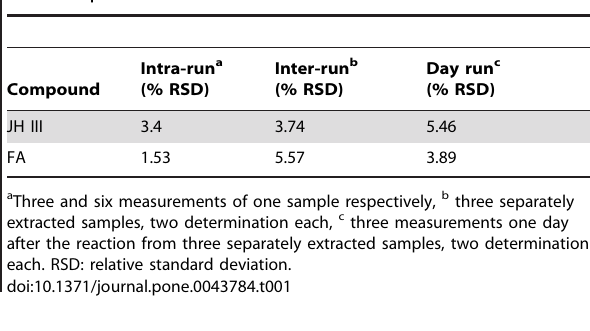
Figure 5. JH III HPLC-FD chromatograms. JH III (100 pmol) samples before and after derivatization are superimposed. JH III (black line) and JH III derivatized with DBD-COCl (JH-tag, grey line). Left Y axes: UV absorbance, right Y axes: fluorescence.